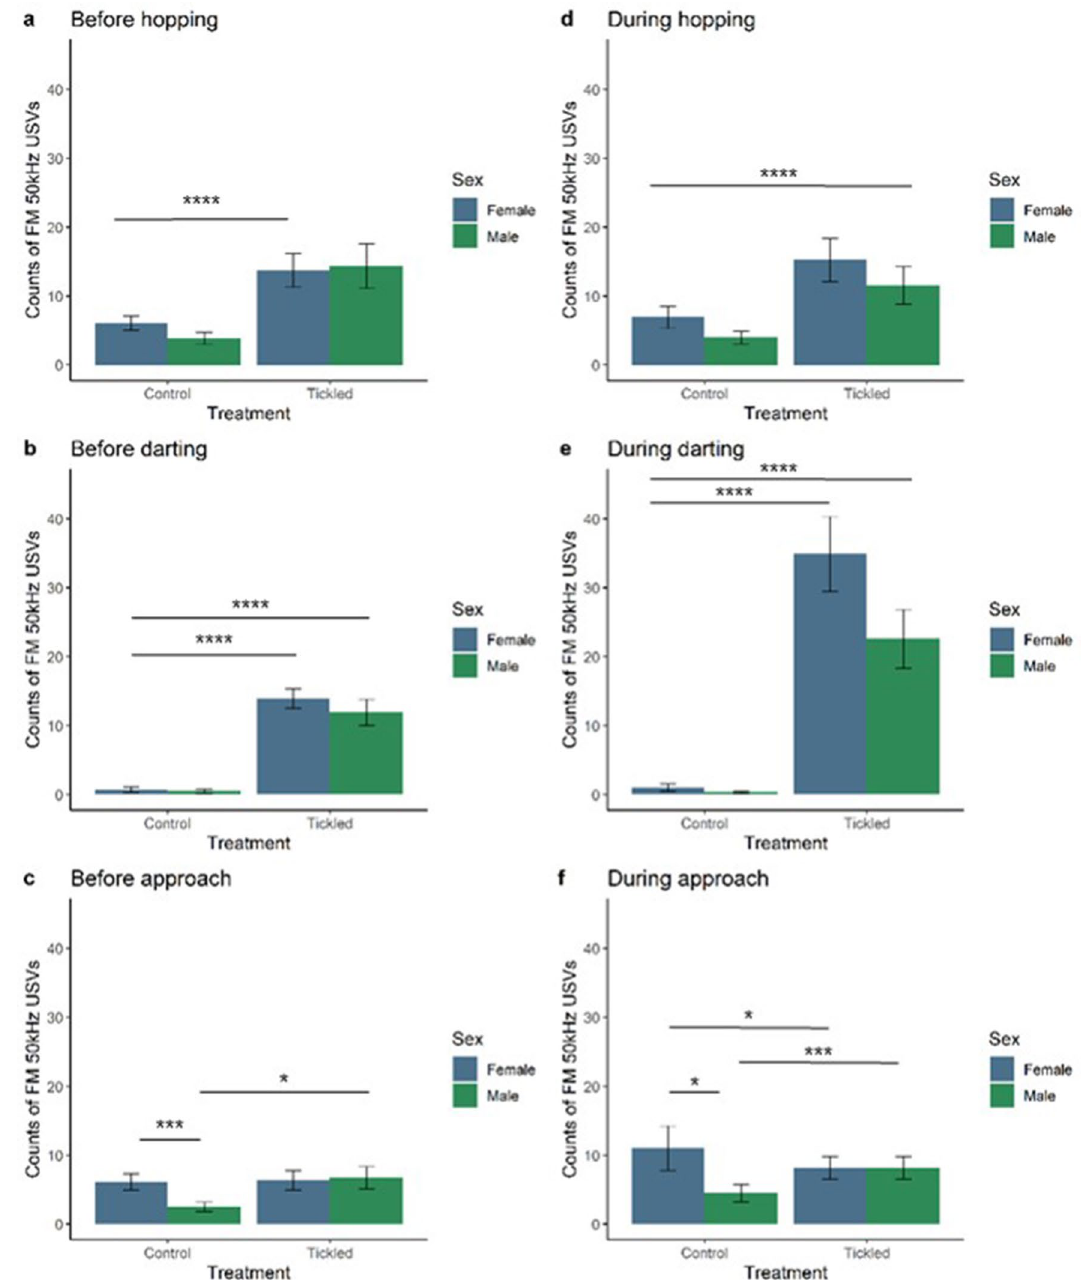
Figure 2. Frequency-modulated (FM) ultrasonic vocalisations (USVs) paired with play-related behaviours in tickled compared to control rats. Estimated marginal means ± 95% CI of FM 50 kHz USVs produced in the one second before hopping ( a ), darting ( b ) and approach to the hand ( c ) ‘play-related’ behaviours, and FM 50 kHz USVs produced during hopping ( d ), darting ( e ) and approach to the hand ( f ) ‘play-related’ behaviours. Female (blue) and male rats (green). n = 16/group. *denotes p ≤ 0.05; **denotes p ≤ 0.01; *** denotes p ≤ 0.001; **** denotes p ≤ 0.0001 for significant pairwise the hand compared to tickled males (t ratio = − 5.37, p < 0.0001) and control females (t ratio = 2.97, p = 0.0219). Similarly, the interaction between treatment and sex had an overall effect on the number of FM USVs emitted during hand approaches (X 2 (1,63) = 23.25, p < 0.0001), with control males making fewer FM 50 kHz USVs during approaches than control females (t ratio = 2.94, p = 0.0236), tickled females (t ratio = 3.11, p = 0.0149) and tickled males (t ratio = − 4.08, p = 0.0008). Tickled rats, regardless of sex, made more FM USVs in the one second before (X 2 (1,63) = 12.13, p = 0.0005) but not during (X 2 (1,63) = 0.22, p = 0.6405) hand approaches as compared to control rats.